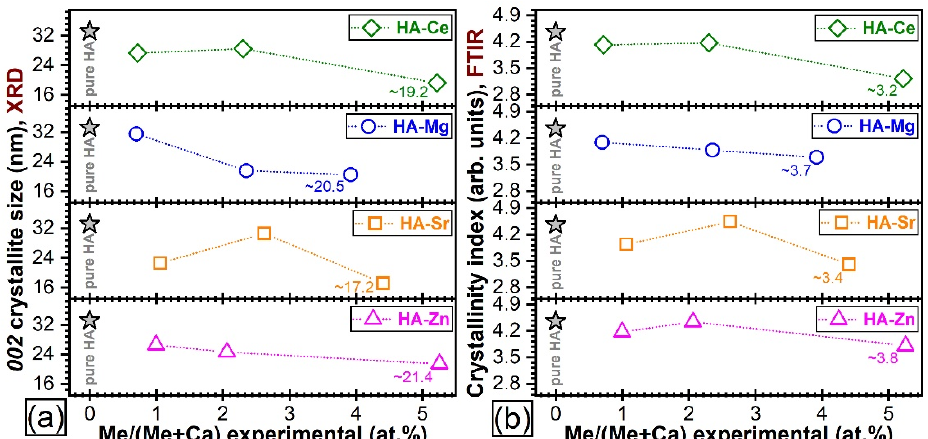
Figure 7. Evolution of the ( a ) crystallite size (as determined on the basis of the Scherrer equation applied to the 002 XRD peak) and ( b ) index of crystallinity (as determined on the basis of FTIR-ATR spectra) with the increase of the substituent concentration. The values inferred in the case of pure HA NPs are presented for comparison.